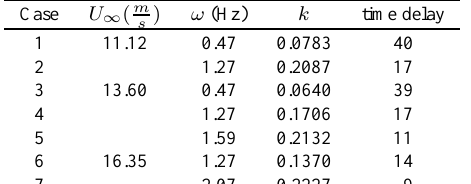
Table 2 Parameters of torsional measurements for oscillating